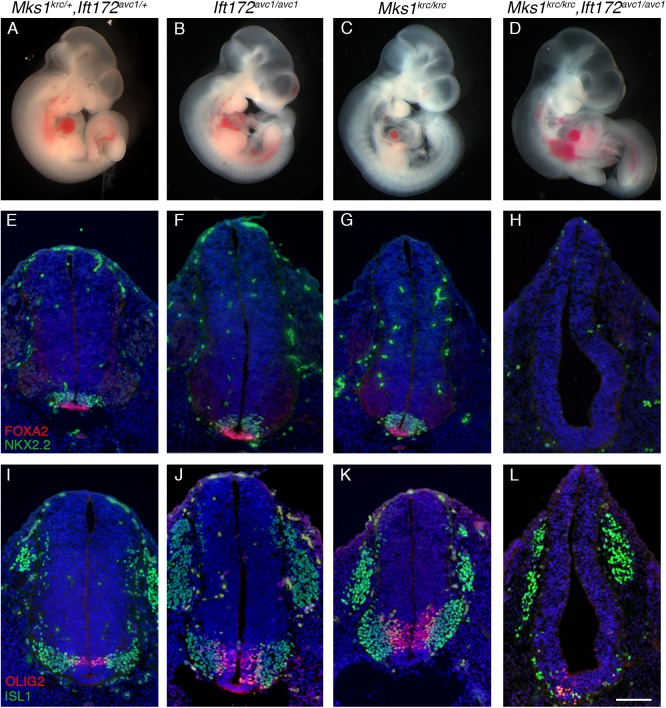
Mks1krc/krc;Ift172avc1/avc1 double mutants exhibit phenotypes consistent with severely reduced Hh signaling.(A-D) Double heterozygous (A), Ift172avc1/avc1 (B), Mks1krc/krc (C), or Mks1krc/krc;Ift172avc1/avc1 double mutant (D) embryos at E10.5. In contrast to Ift172avc1/avc1 or Mks1krc/krc single mutant embryos, double mutants exhibit a pointed midbrain flexure, enlarged branchial arches, and a twisted body axis reminiscent of other mutants in which cilia are absent or ciliogenesis is severely perturbed. (E-L) Transverse sections through the neural tube of embryos of the indicated genotype at E10.5. Sections were taken at the level of the forelimbs and immunostained with antibodies against FOXA2 (red) and NKX2.2 (green) in E-H, or OLIG2 (red) and ISL1 (green) in I-L. Scale bar, 100μm.